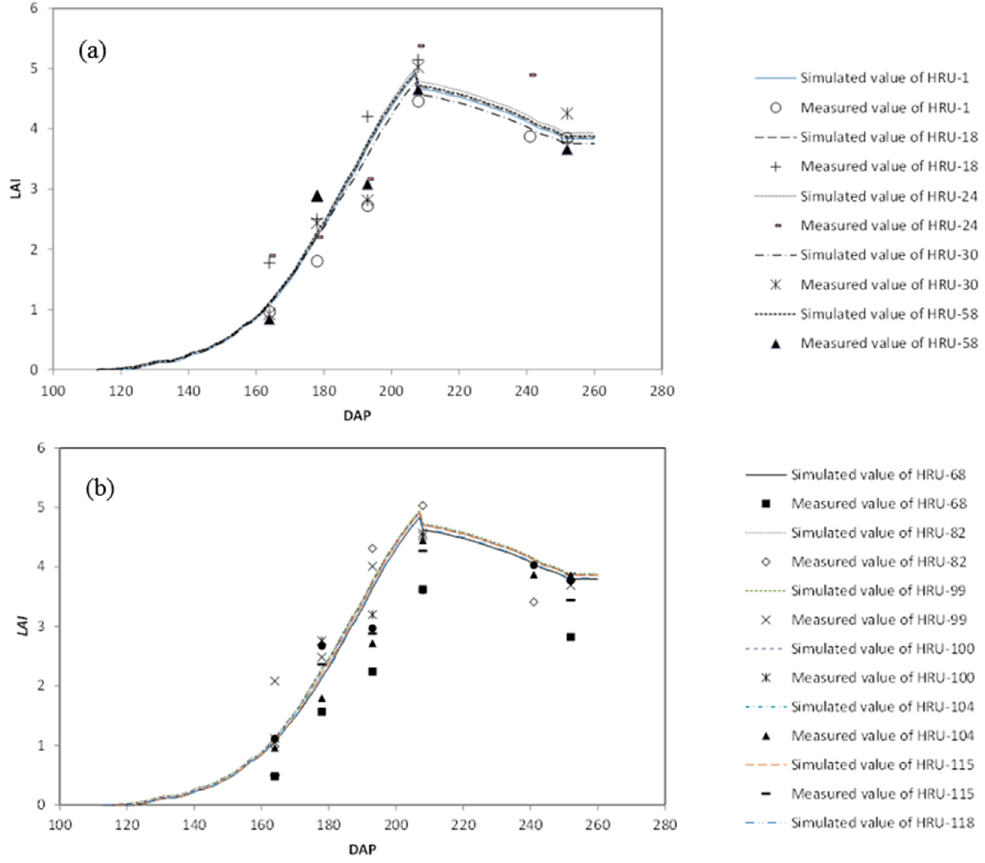
Figure 8. Typical variations in simulated and measured LAI values (( a ) values for calibration; and ( b ) values for validation; DAP is day after planting). Table 8. Statistical parameters related to the simulation of LAI in the calibration and validation phases.